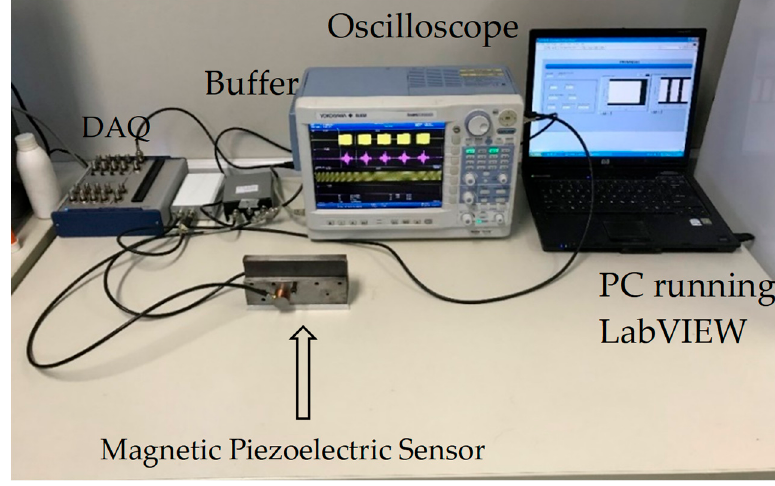
Figure 1. Experimental